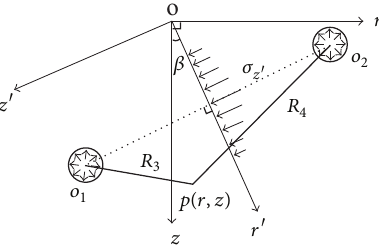
Figure 5: The stress distribution of the slope